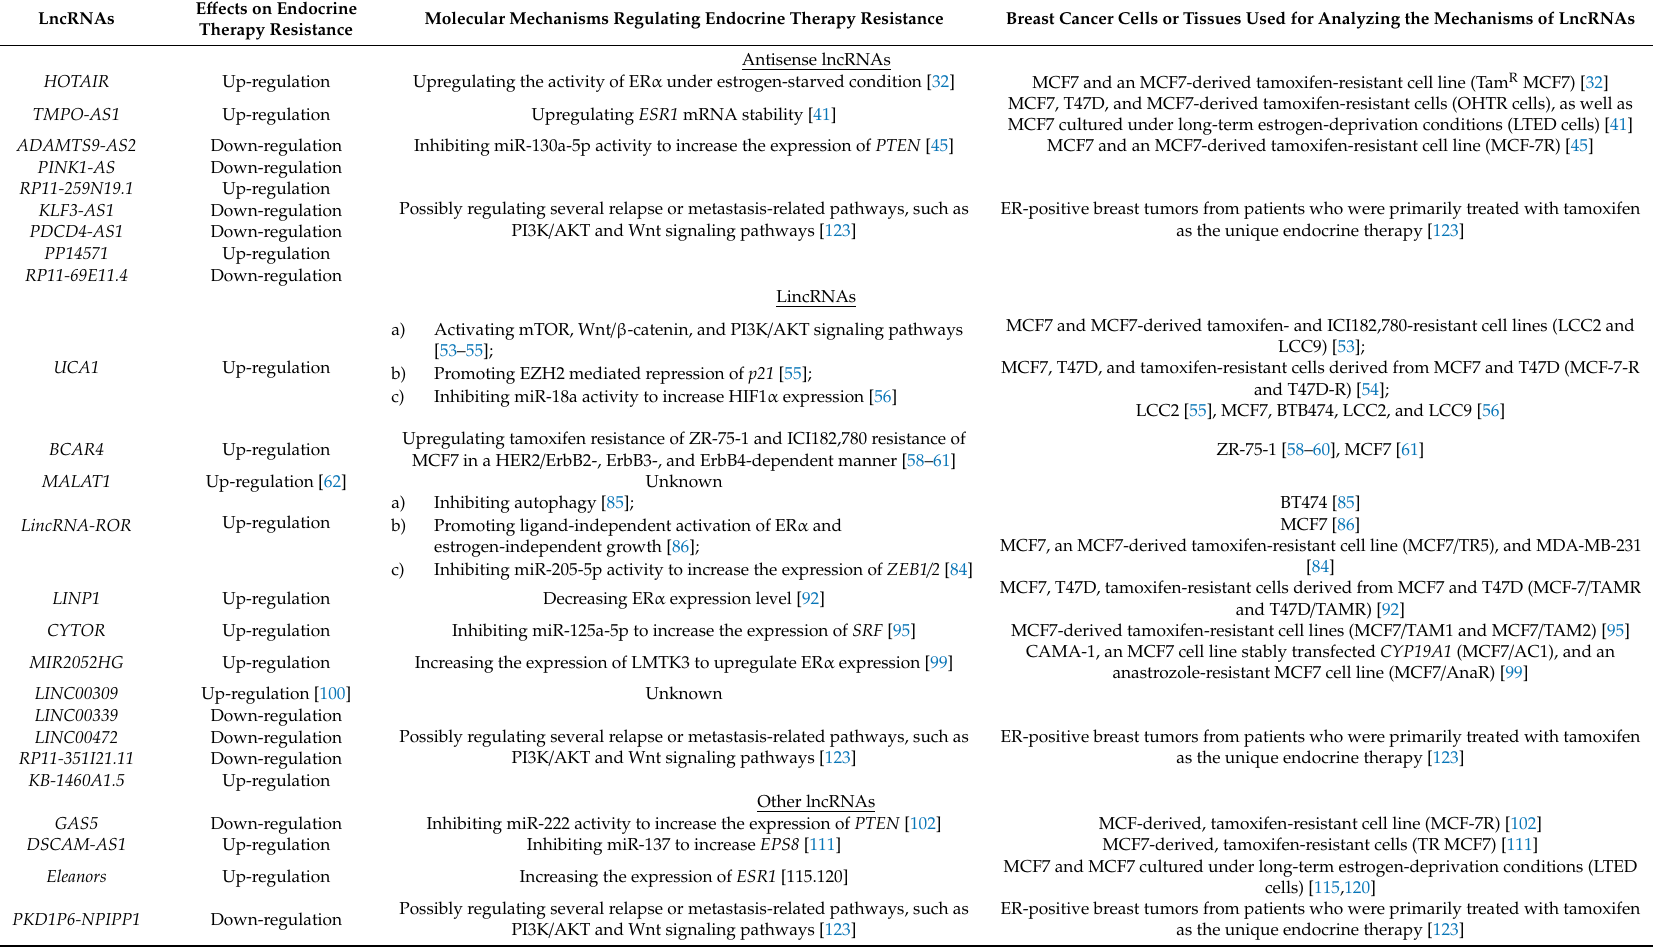
Table 1. LncRNAs regulating endocrine therapy resistance in breast